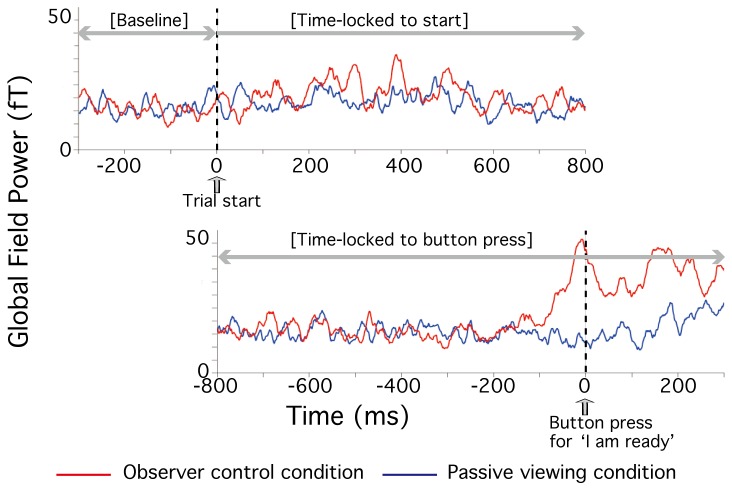
Examples of MEG data.The obtained data arranged: (1) time-locked to the start of the trial (Top panel), and (2) time-locked to the button press (Bottom panel). Examples of MEG data are shown for participant TT in both the observer-control condition (shown in red) and the passive control condition (shown in blue).